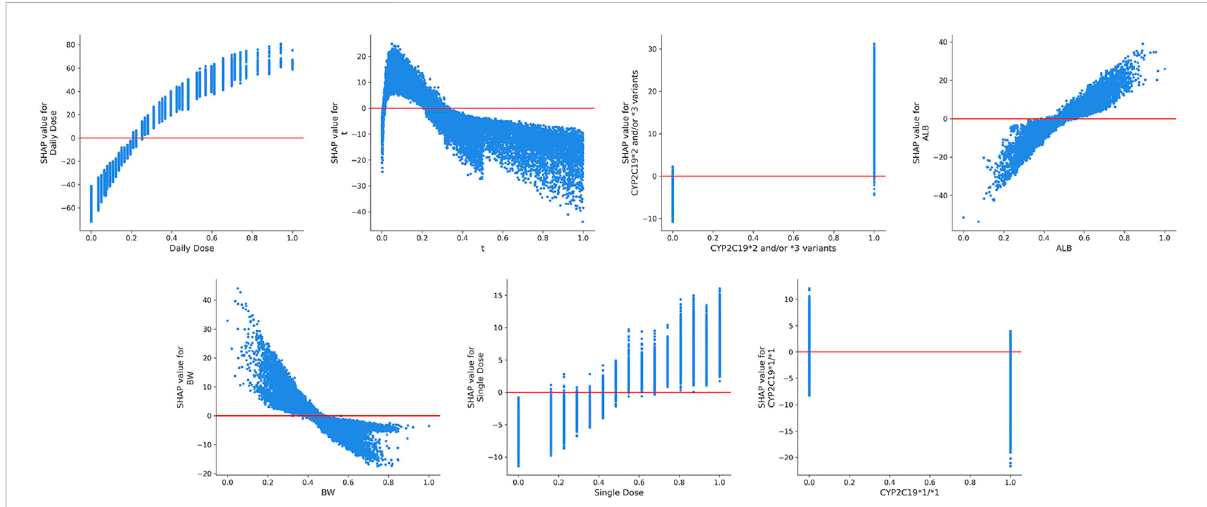
FIGURE 5 The SHAP dependence plots of features that ranked higher according to their importance ranking. From the scatter plots, we can see the exact form of the relationships between a single feature and the predictions made by the model.